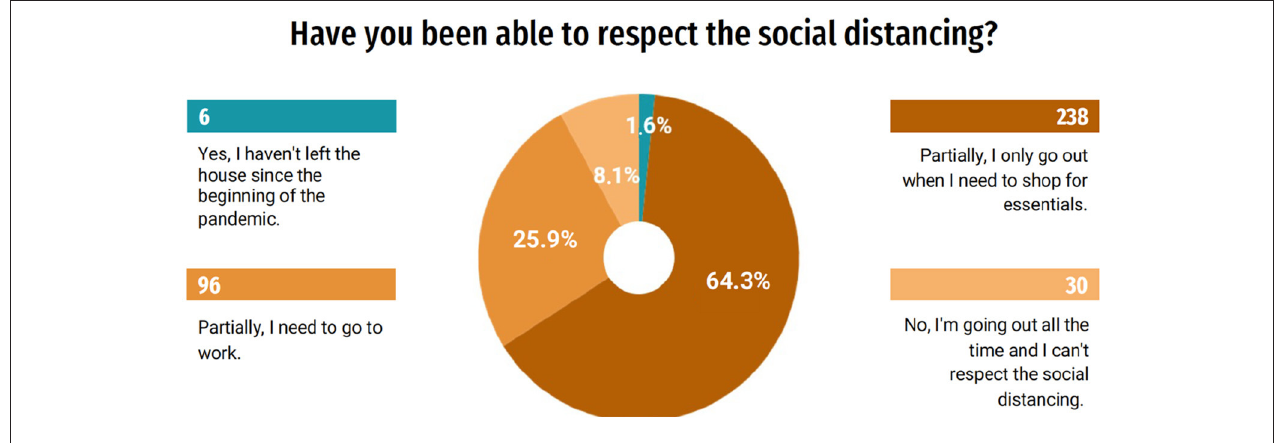
FIGURE 1 | Respect for the recommended social distancing.